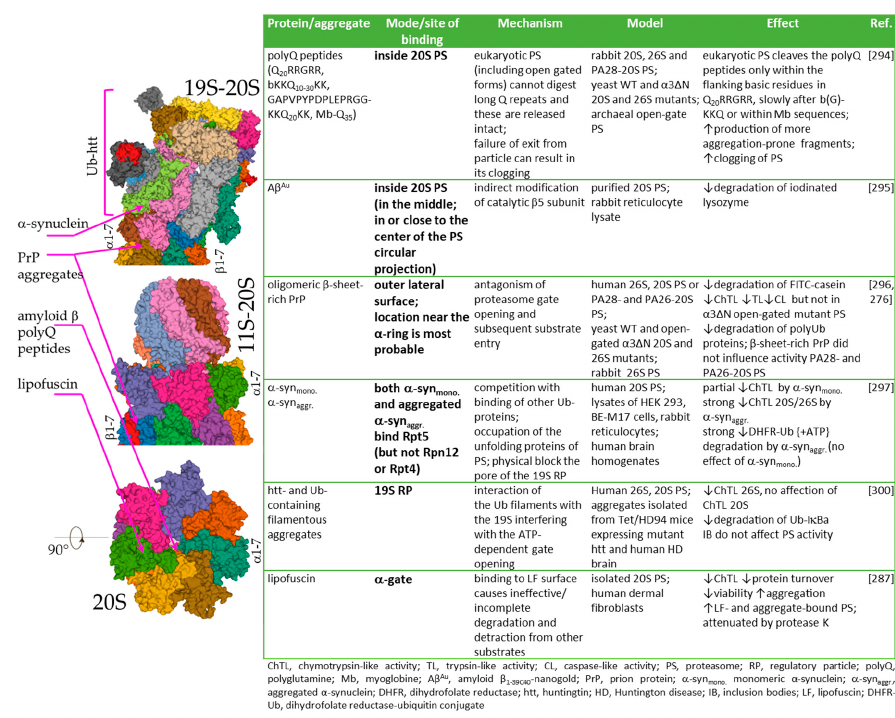
Figure 2. Proposed mechanisms of interaction of the proteasome with aggregated proteins. Aggregated proteins as well as monomers were shown to interact with the lateral side of CP or the 19S regulatory particle. PolyQ repeats lacking Ub modification or amyloid β peptide can occupy the internal proteasome cavity. Images are from the RCSB PDB (rcsb.org) of PDB ID: 5A5B [65,66], 6XMJ [65,298], 1G0U [65,299].